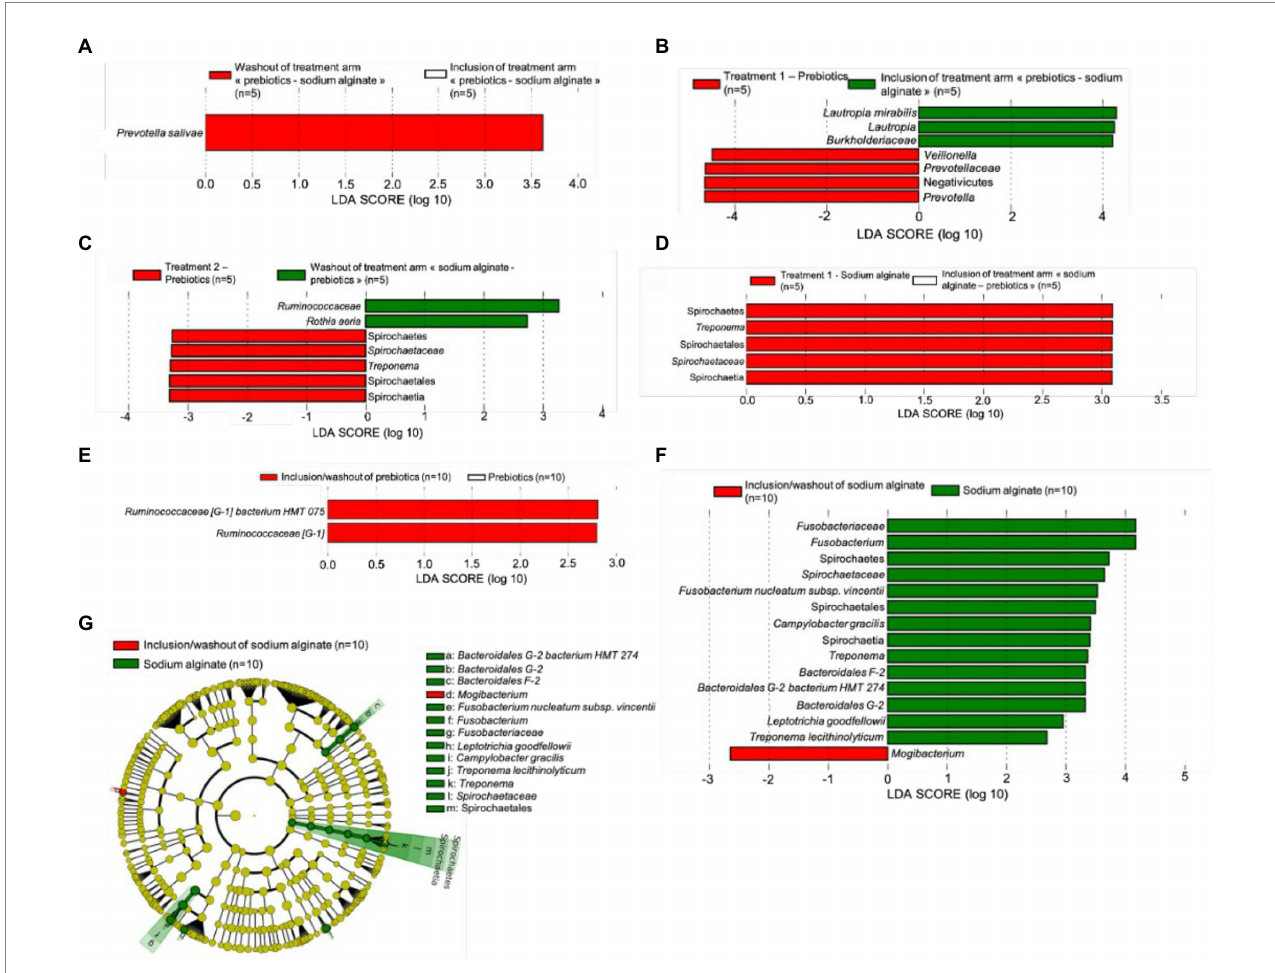
FIGURE 5 Linear discriminant analysis effect size (LEfSe) of significant taxa (A) with a different relative abundance between inclusion and washout time points of the treatment arm “prebiotic biofilms-sodium alginate biofilm,” (B) indicating effect of the prebiotic biofilm in the first phase (D0 versus D30), (C) indicating effect of the prebiotic biofilm in the second phase (D60 versus D90), (D) indicating effect of the sodium alginate biofilm in the first phase (D0 and D30), (E) indicating overall effect of the prebiotic biofilm from the start to the end of study, (F) indicating overall effect of the sodium alginate biofilm from the start to the end of study, and (G) cladogram representing the overall effect of the sodium alginate biofilm from the start to the end of study. The length of the bar represents a log10 transformed LDA score, which was computed by the algorithm by the Galaxy web